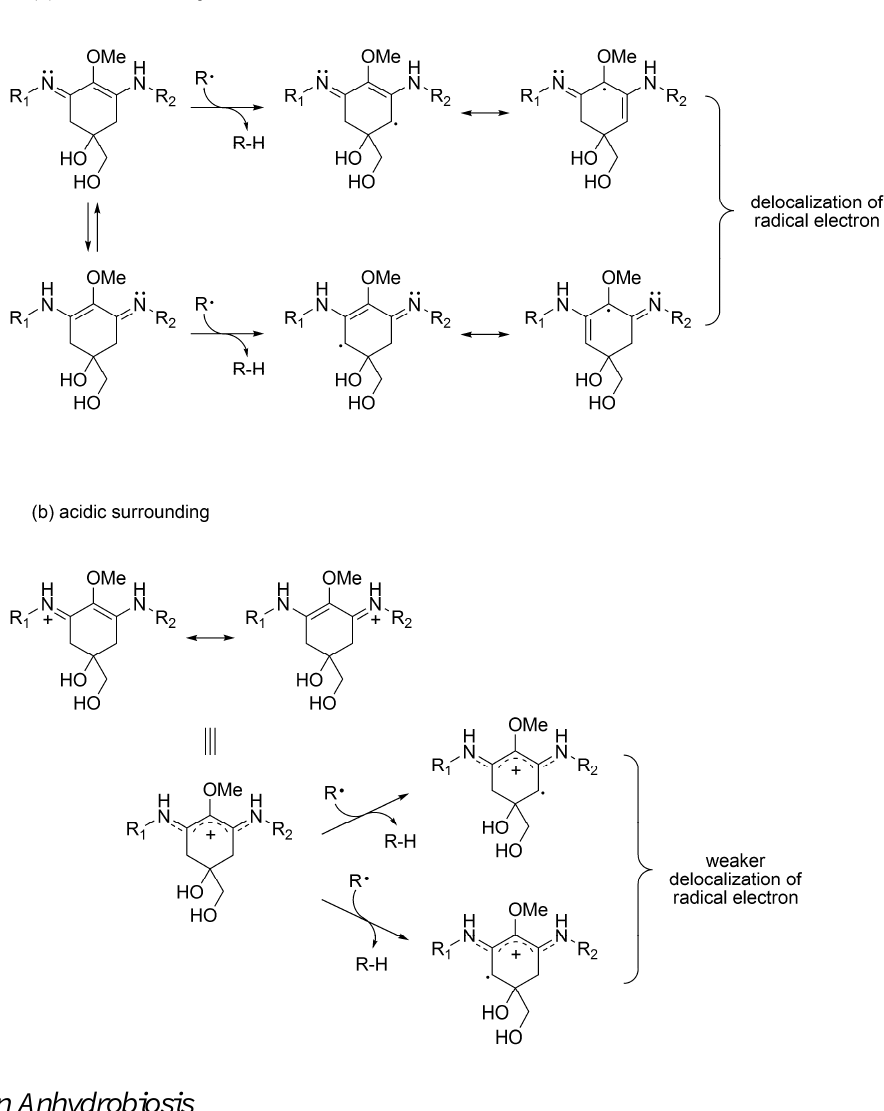
Figure 4. Stabilization by resonance of radical electron at the C-4 and C-6 position